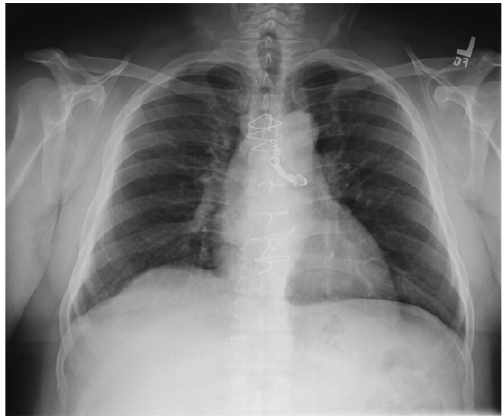
Figure 1: Chest radiograph shows a dental prosthesis lodged in the left mainstem